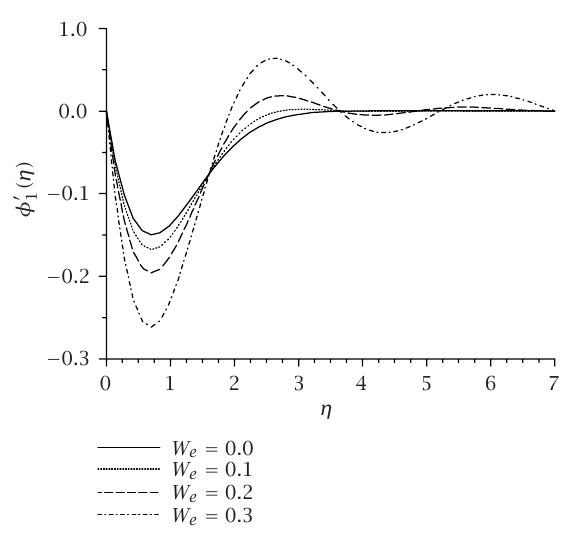
Figure 3.4 . Variation of φ (cid:6)